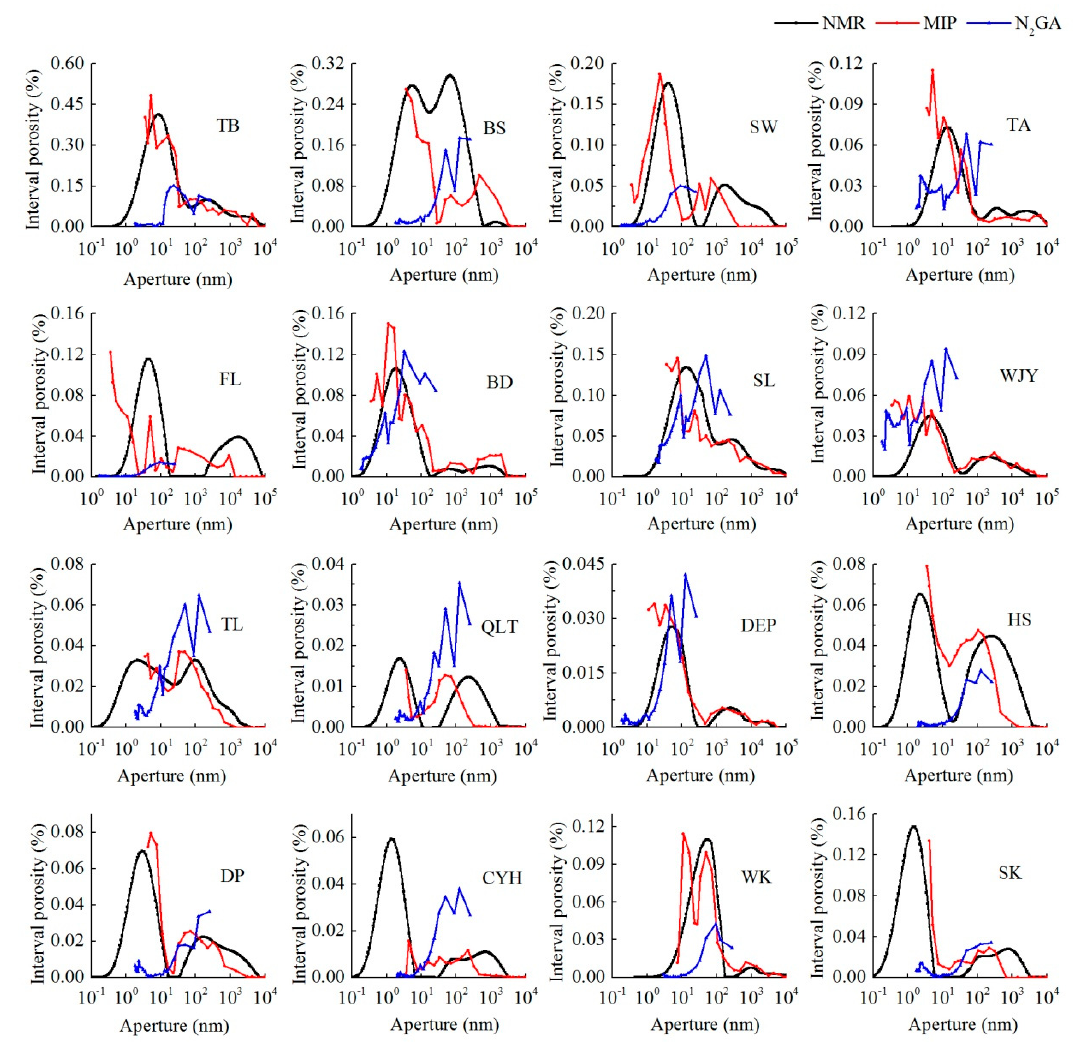
Figure 10. Pore size distribution (PSD) comparison of coal samples from nuclear magnetic resonance (NMR), mercury intrusion porosimetry (MIP) and nitrogen adsorption (N 2 GA) techniques.